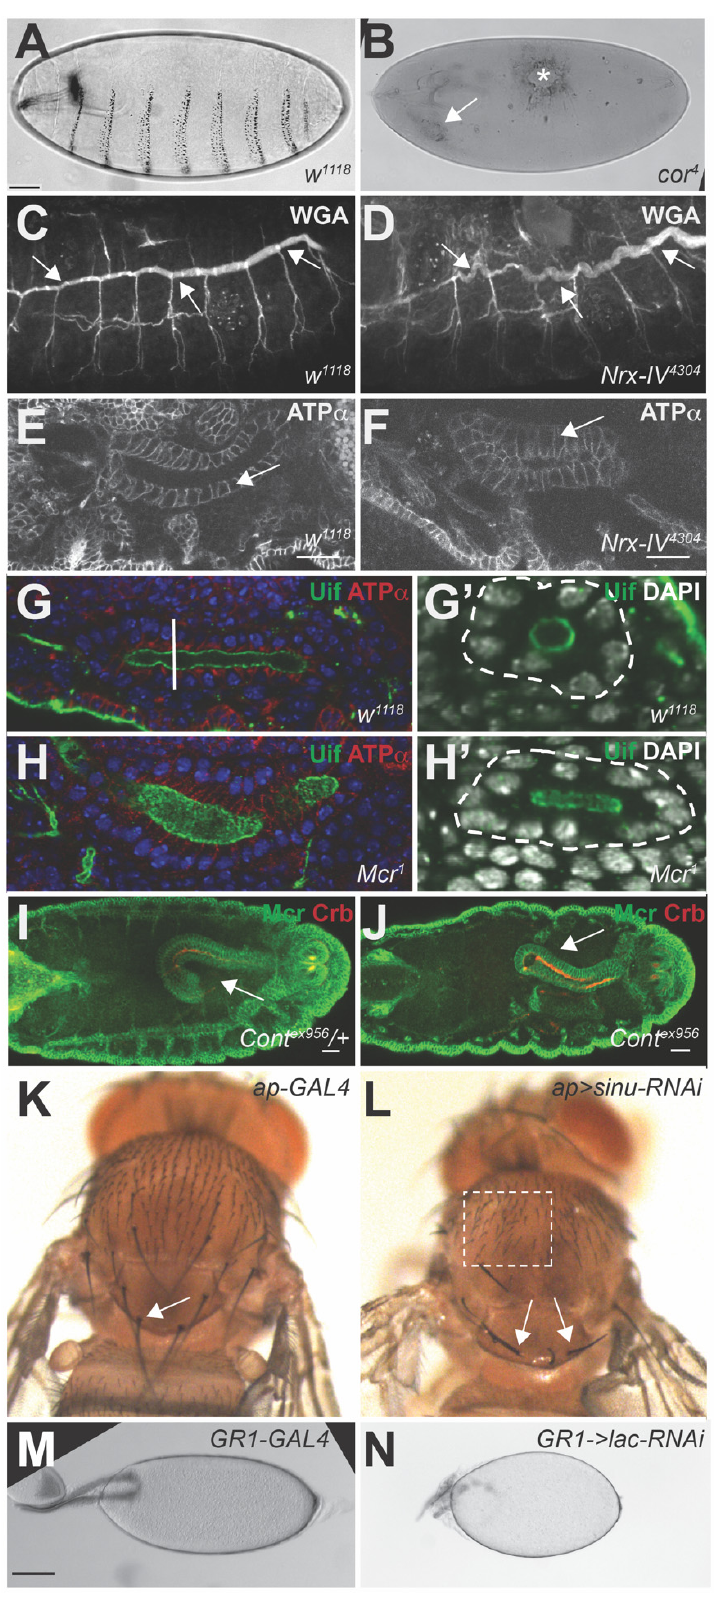
Figure 2. Embryonic phenotypes associated with SJ mutations. ( A , B ) Cuticle preparations of w 1118 ( A ) and cor 4 ( B ) embryos showing defective dorsal closure (asterisk in ( B )) and extra cuticle deposits in the region of the salivary gland (arrow in ( B )). ( C , D ) Wheat germ agglutinin stained stage 17